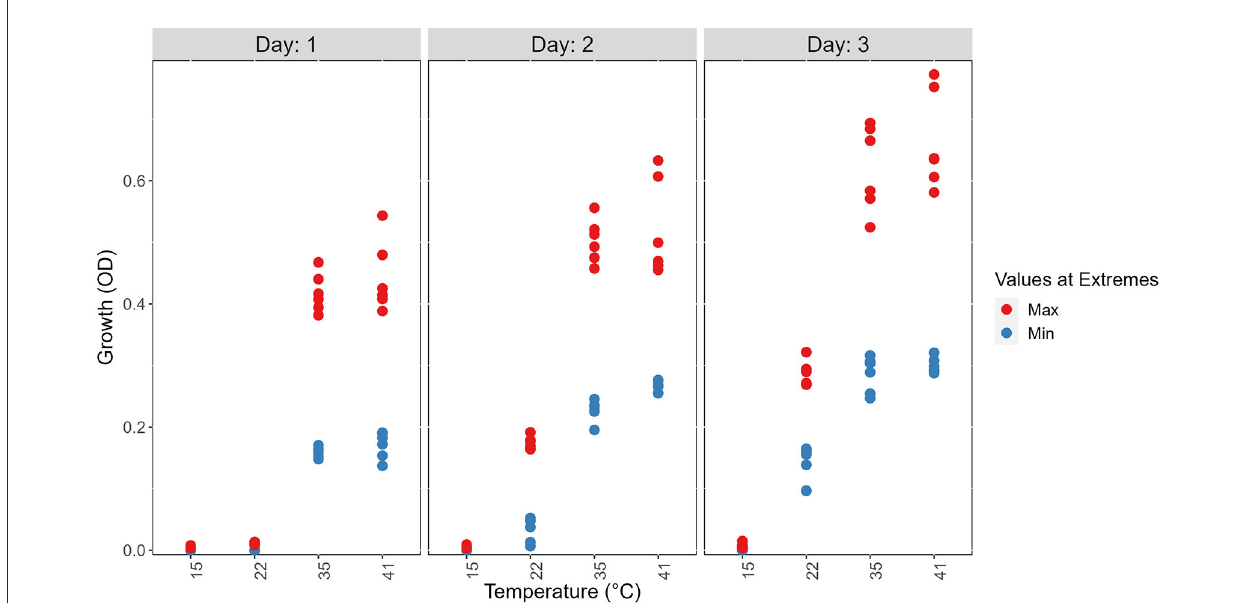
FIGURE3 Visual representations of the top six fastest growing strains and the bottom six slowest growing ones at each of the four temperatures on 3 days to show the range of growth difference of A. fumigatus strains. The top 6 (Max) are shown in red and the bottom 6 (Min) are shown in blue.